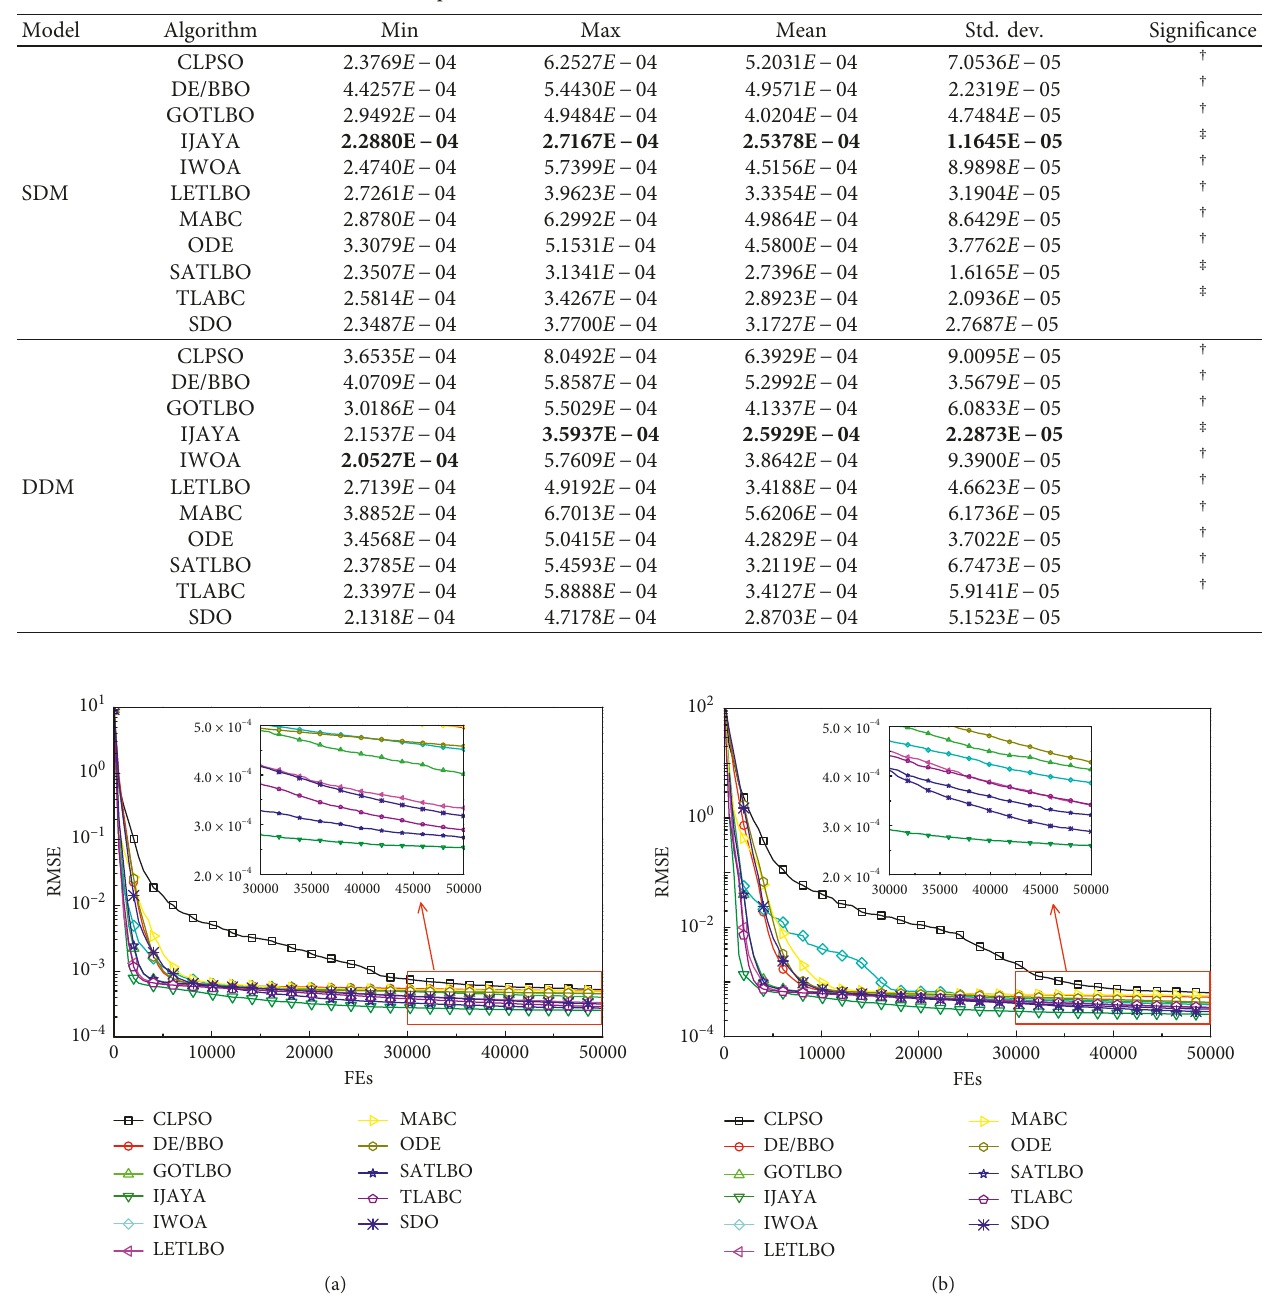
Table 6: Experimental results on the PVM 752 GaAs thin film cell.